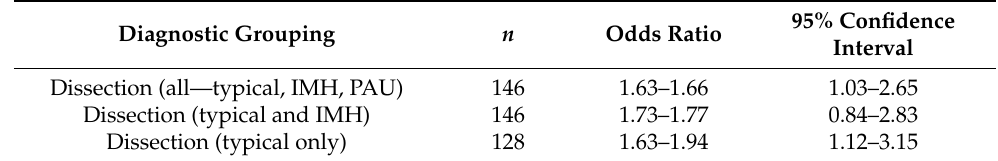
Table 5. Summary table. Impact of KIF6 719Arg positivity on probability of aortic dissection. Ranges under the odds ratio indicate the lowest and highest adjusted levels depending on exact genotype (Arg/Arg + Arg/Trp, Arg/Arg, or Arg/Trp). Extracted for clarity from Table